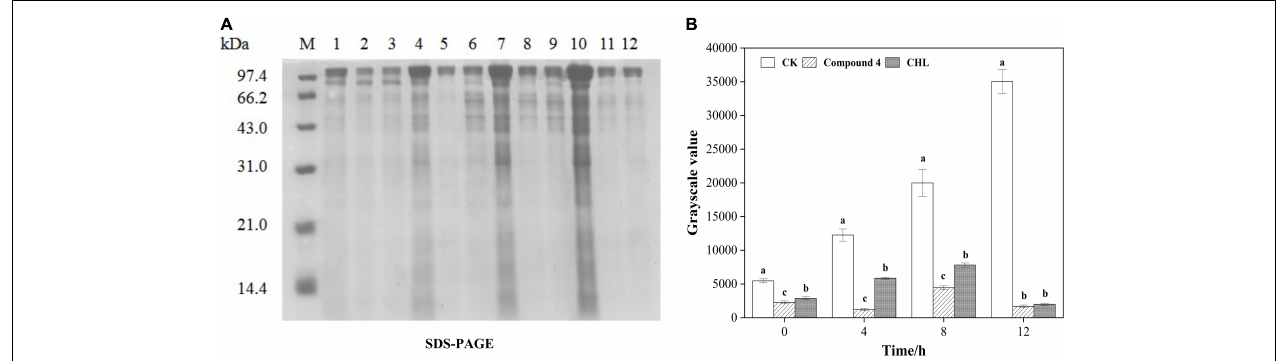
FIGURE 8 | Effect of compound 4 on protein synthesis in RS-2 cells. (A) SDS-PAGE of RS-2 cells treated with compound 4. M: Maker; 1, 4, 7, and 10 were the control treatments of 0, 4, 8, and 12 h, respectively. 2, 5, 8, and 11 were treated with compound 4 at 0, 4, 8, and 12 h, respectively. 3, 6, 9, and 12 were treated with chloramphenicol for 0, 4, 8, and 12 h, respectively. (B) The grayscale value map of the effect of compound 4 on protein synthesis of RS-2. Different lowercase letters indicate significant differences among treatments at the same exposure time ( p <